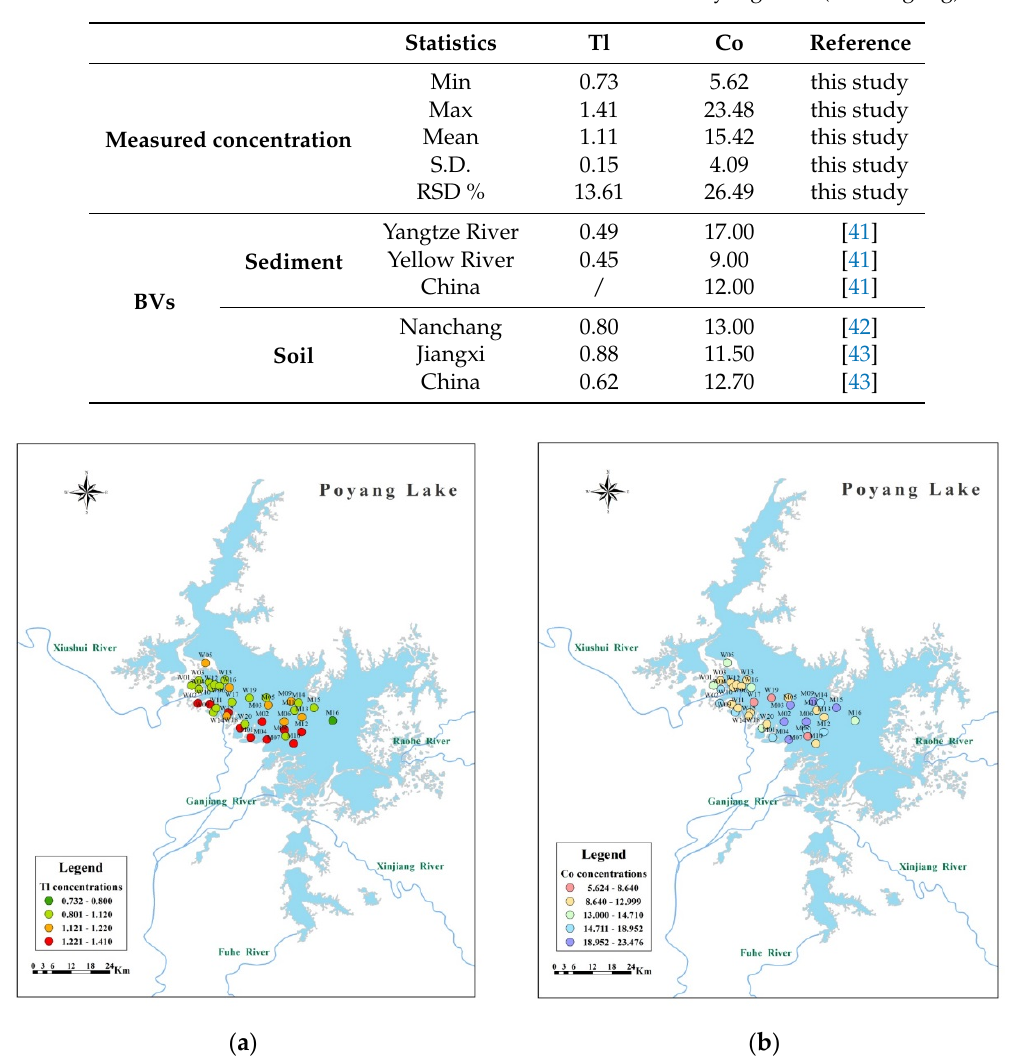
Figure 2. Tl and Co concentrations in the surface sediments of Poyang Lake. ( a ) The spatial pattern of Tl in the study area; ( b ) the spatial pattern of Co in the study